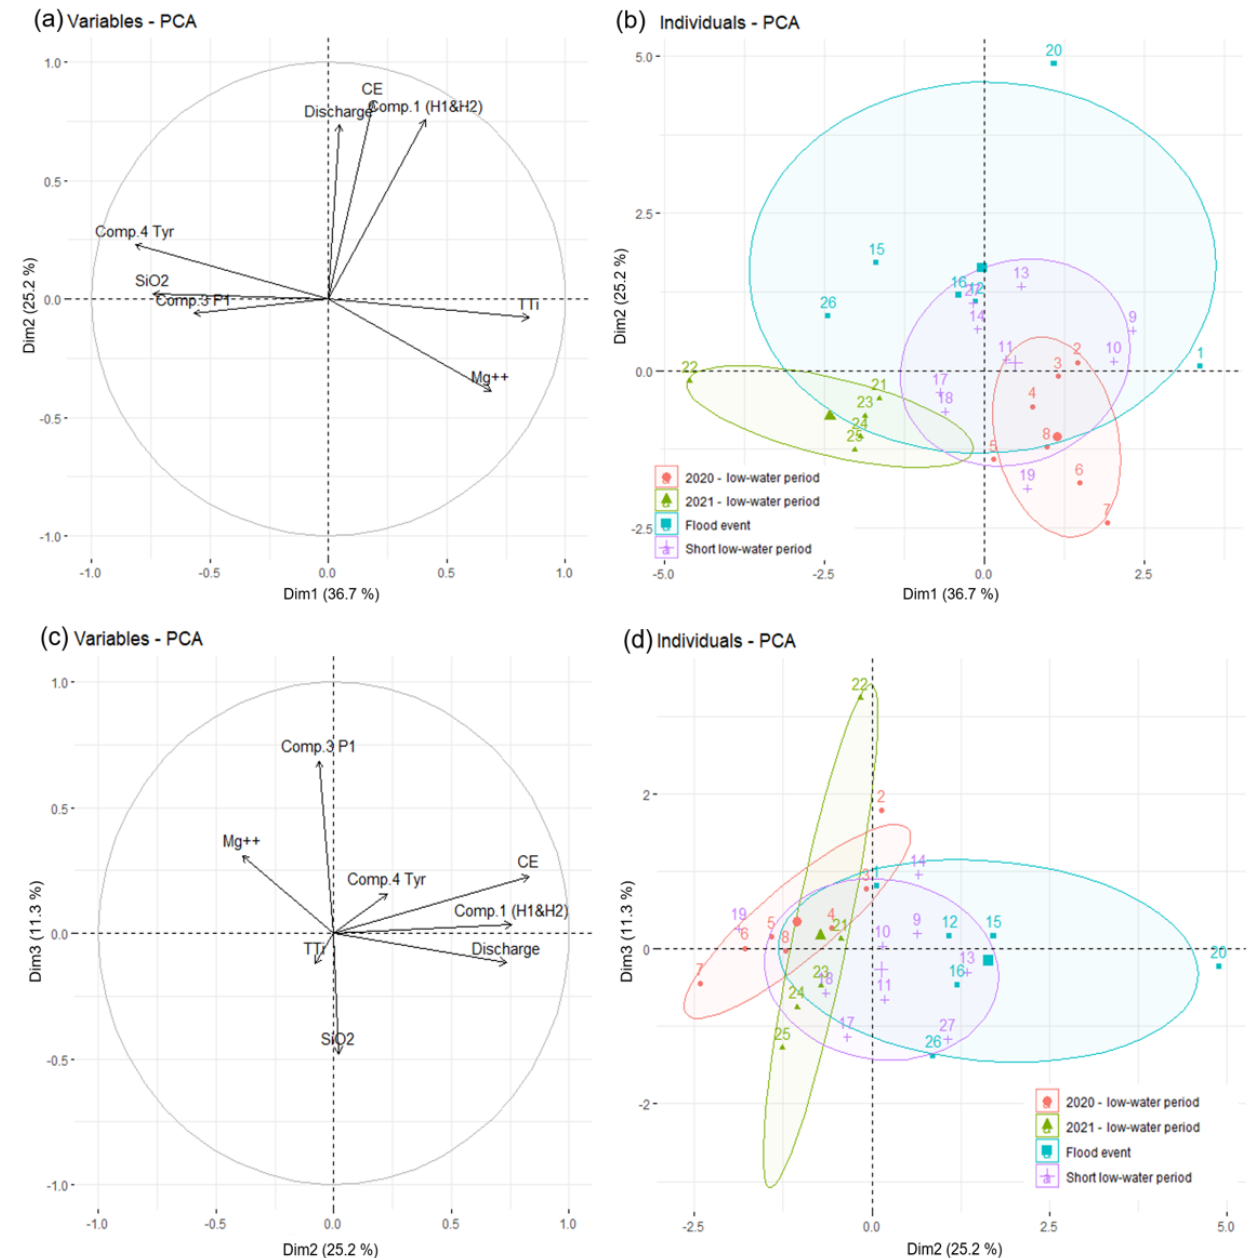
Figure 6. PCA performed with Millet spring samples thanks to the following variables: TTi components, TTi, SiO 2 , Mg 2 + , electrical conductivity, and discharge. Dimensions 1 and 2 are presented in (a) and (b) and dimensions 2 and 3 in (c) and (d) . Panels (a) and (c) show variables. Panels (b) and (d) show individuals, where point color corresponds to hydrodynamic periods (see Fig. 4) and point label to sample number (see Fig. 4), and the confidence ellipse is